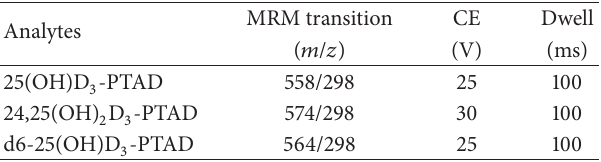
Table 1: Mass spectrometry conditions.